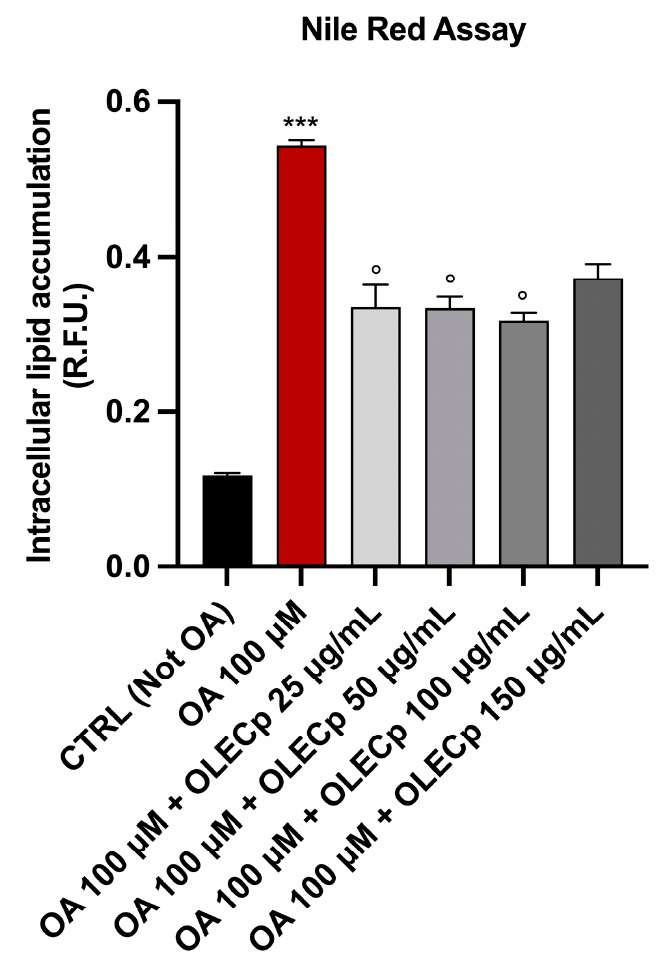
Figure 10. Totally fatty acid accumulation assessed by Nile Red Assay. Intracellular lipid accumulation in McA-RH7777. The results are expressed as mean ± S.E.M; ***: p < 0.001 vs. CTRL; ◦ : p < 0.05 vs. OA 100 μ M.